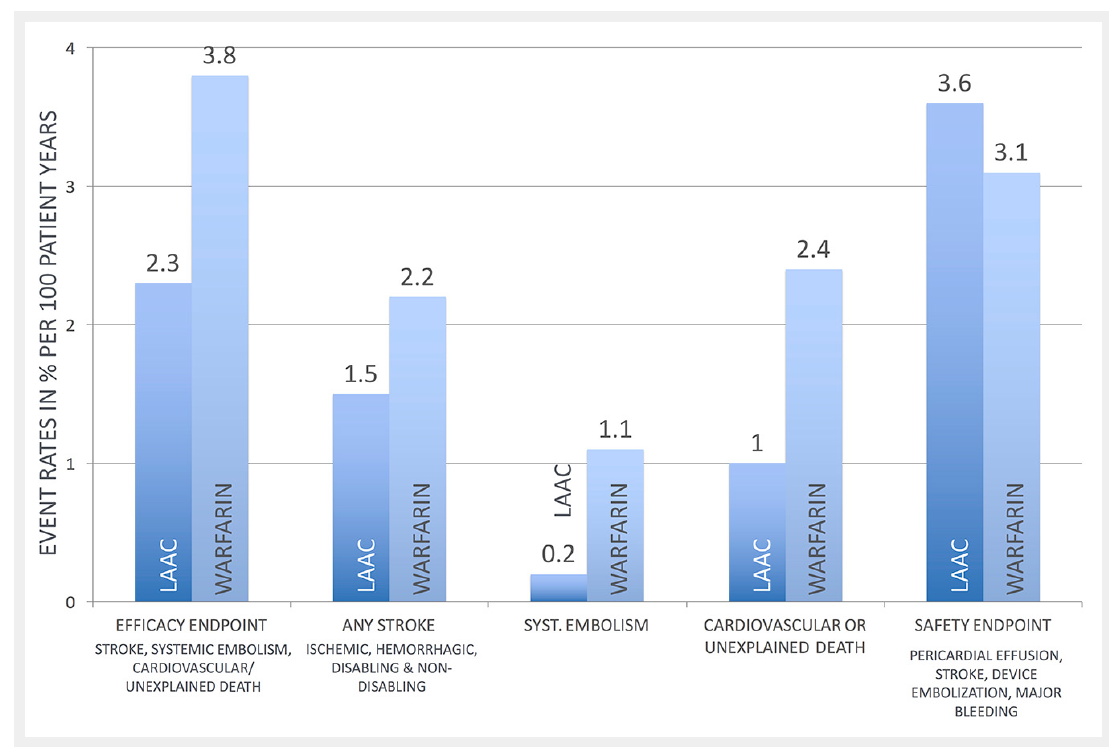
Figure 2 Primary outcomes of the Percutaneous Closure of the Left Atrial Appendage Versus Warfarin Therapy for Prevention of Stroke in Patients with Atrial Fibrillation (PROTECT AF) study [54]. In comparison with warfarin, left atrial appendage closure (LAAC) with the Watchman was superior in preventing death, stroke, and systemic embolism. Due to periprocedural safety events, e.g., severe bleeding as a result of major pericardial effusion, device embolisation and stroke, LAAC with the Watchman device was not superior (yet not inferior either) to warfarin during a mean follow-up time of 3.8 years with regard to safety. For the first time, LAAC has not only shown superior results with regard to stroke prevention, but remarkably also with regard to all cause and cardiovascular mortality, indirectly pointing towards the hazards of oral anticoagulation. Data reproduced from Reddy et al.